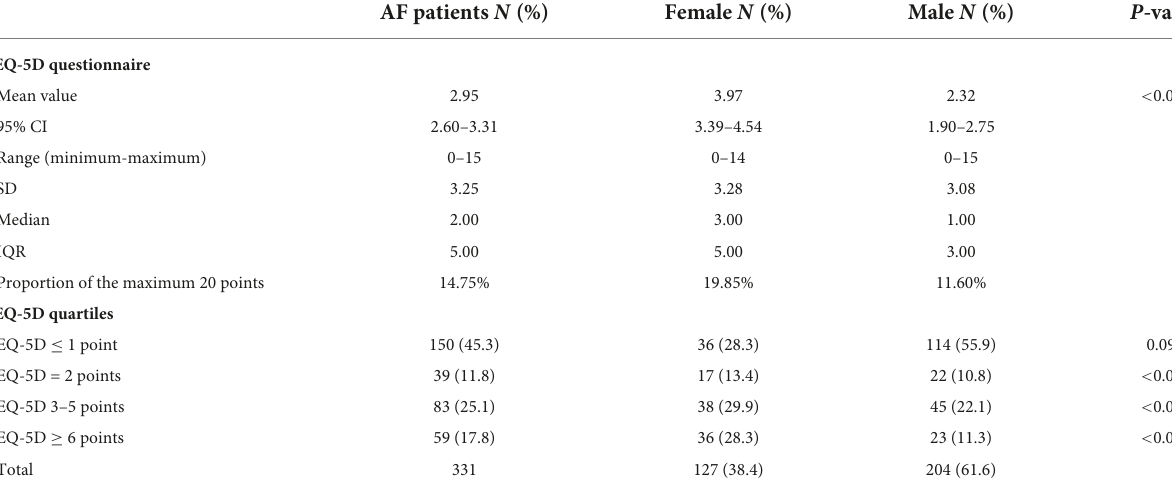
TABLE 4 The distribution of study cohort per quartiles of EQ-5D questionnaire in atrial fibrillation